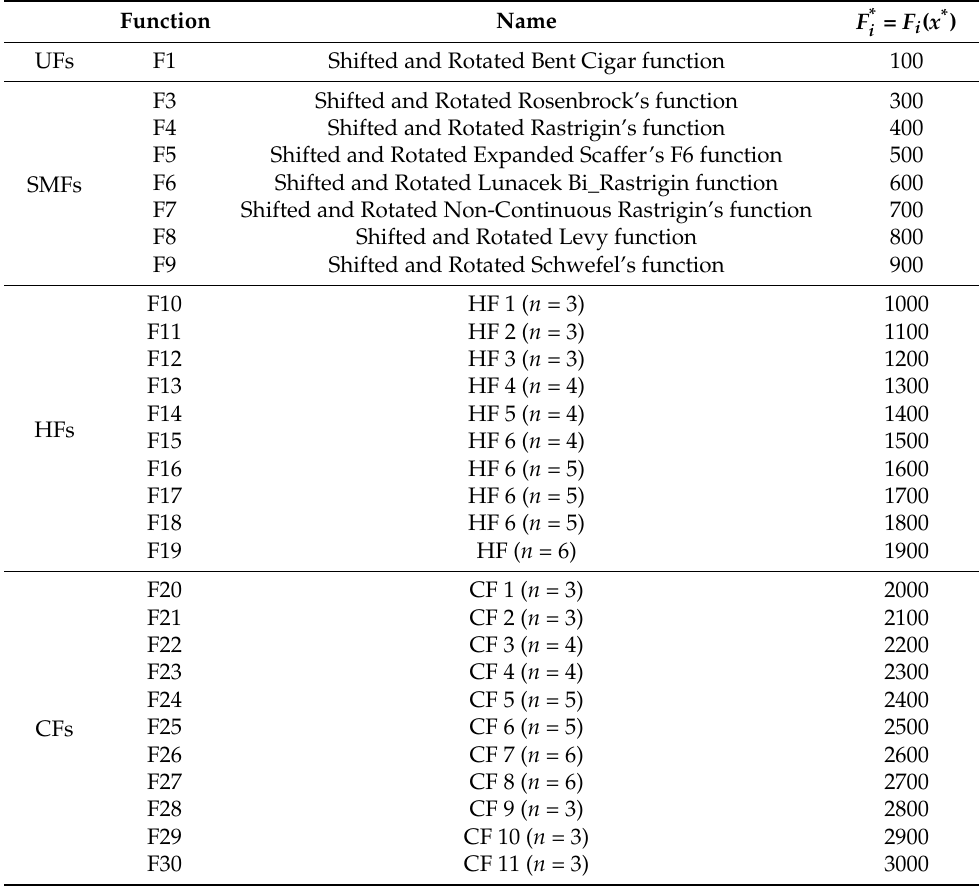
Table 1. Descriptions of CEC 2017 benchmark functions.